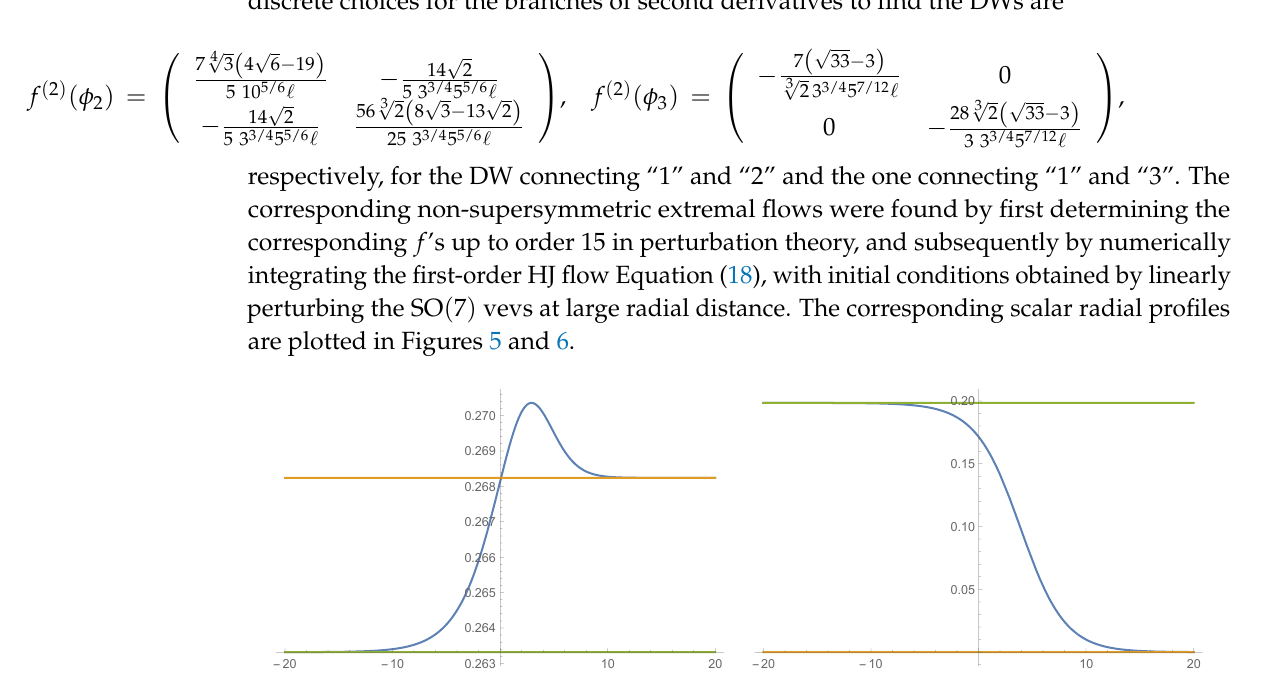
Figure 5. The profiles of ϕ ( r ) ( left ) and χ ( r ) ( right ), plotted against r the ones in the SUSY-G 2 vacuum as r → − ∞ , while they approach those in the non-SUSY SO ( 7 ) as r → + ∞ .